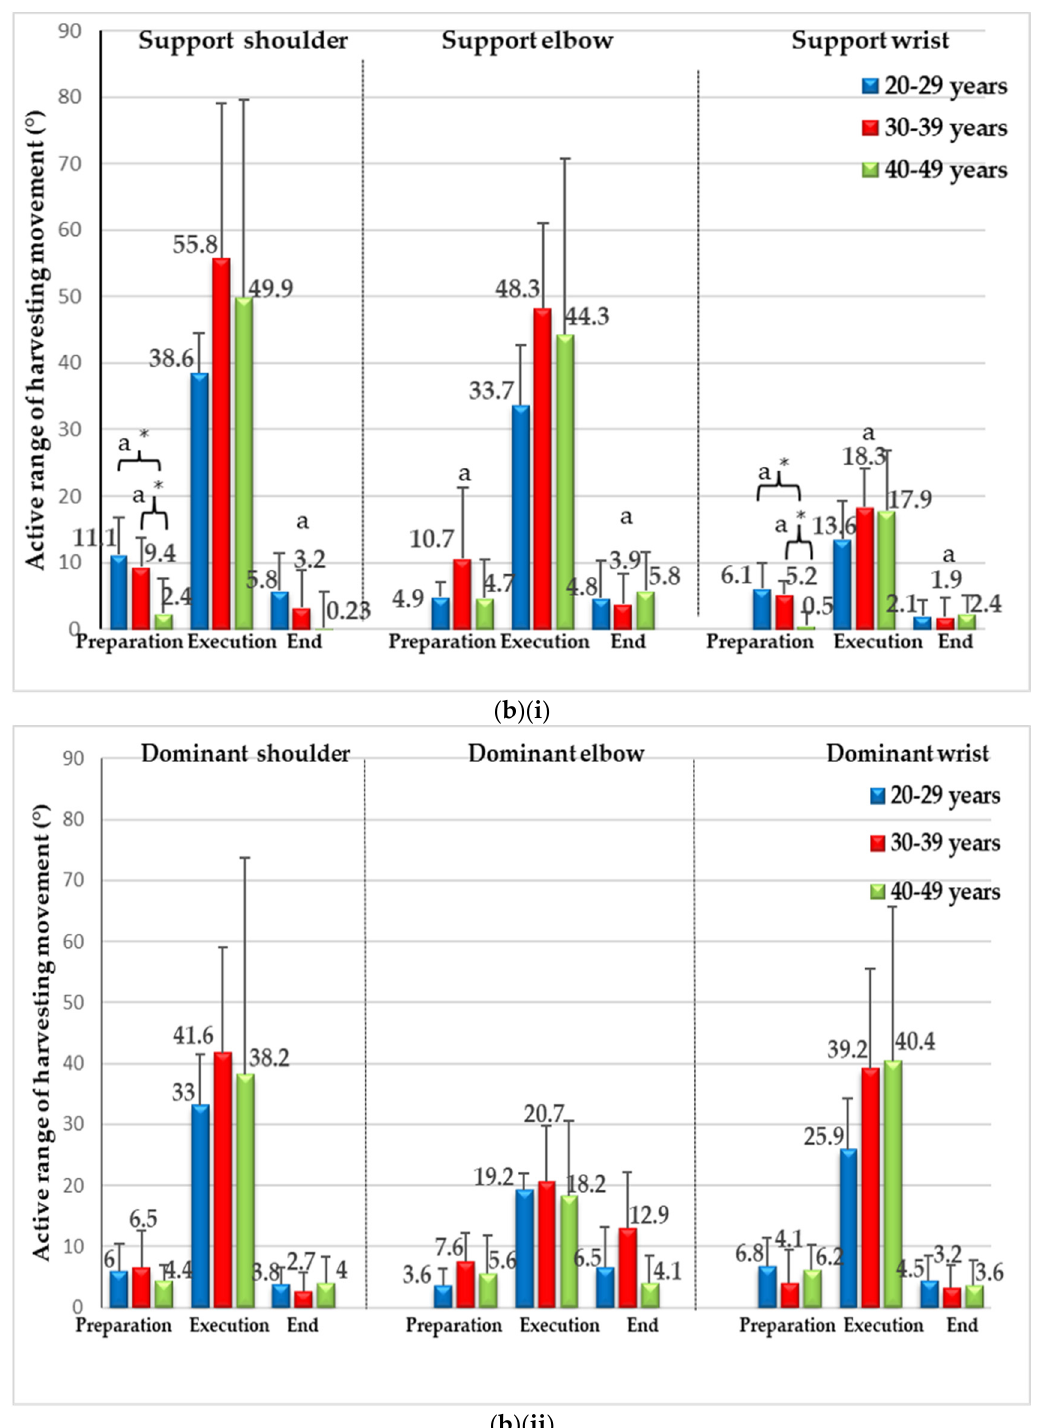
Figure 7. ( a ) The range of harvesting movements for initial and maximum postures and ( b ) the active range of harvesting movements during the three phases of the push-pull-cutting movement by age group for ( i ) the support arm and ( ii ) the dominant arm. The asterisk * denotes statistically significant differences and the letter a denotes that the measures were transformed into normal distributions.